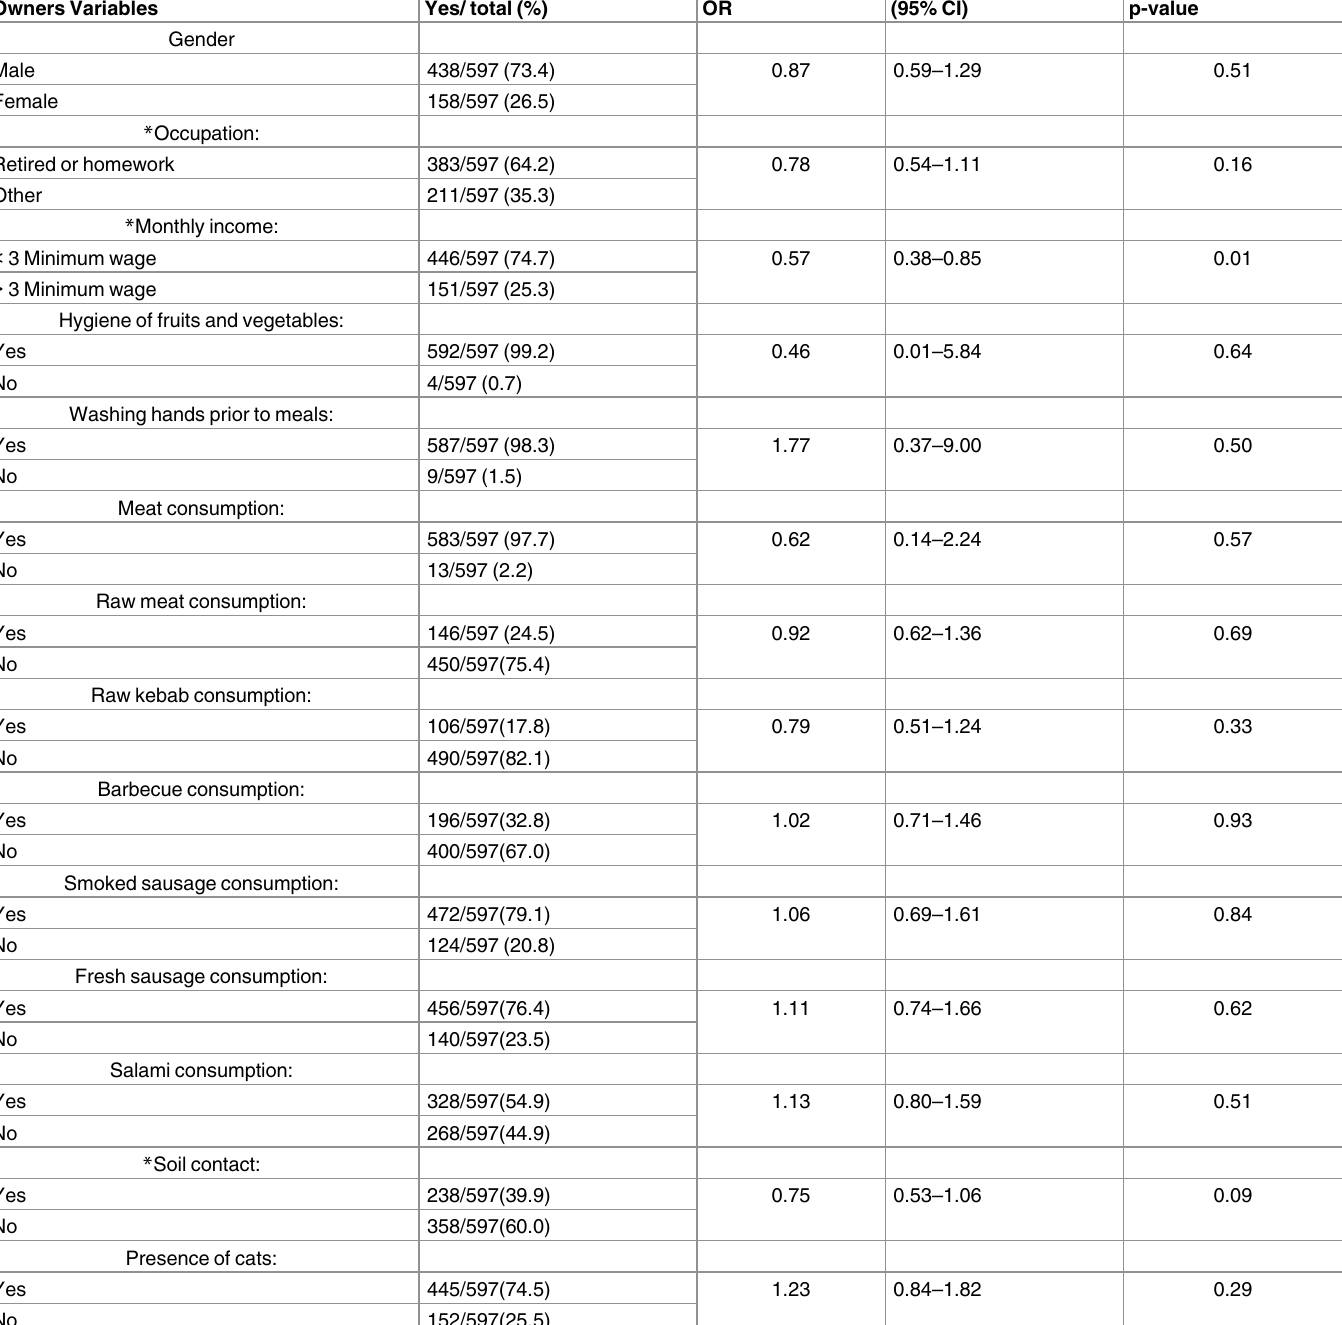
Table 2. Results of univariate logistic regression analysis of 597 owners with IgG anti- T . gondii antibodies detected by IFAT in the urban area of Londrina from July 2015 to July